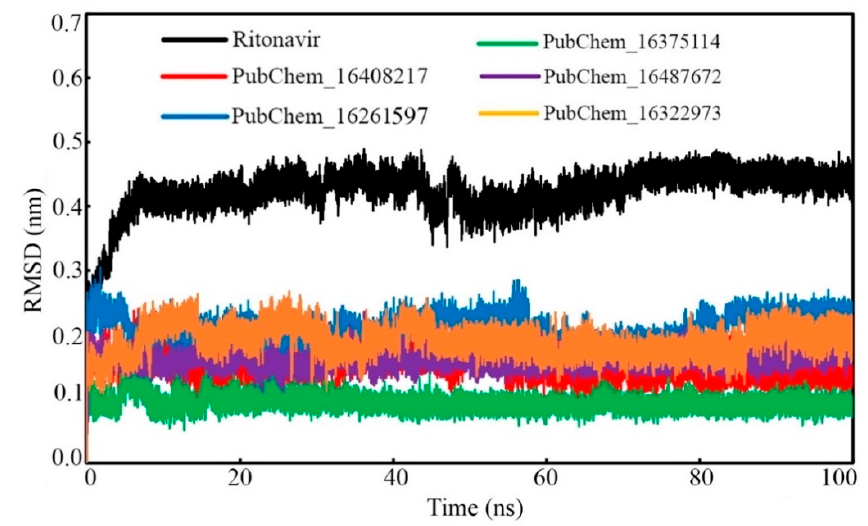
Figure 10. RMSD of proposed CYP3A5 molecules and RIT.